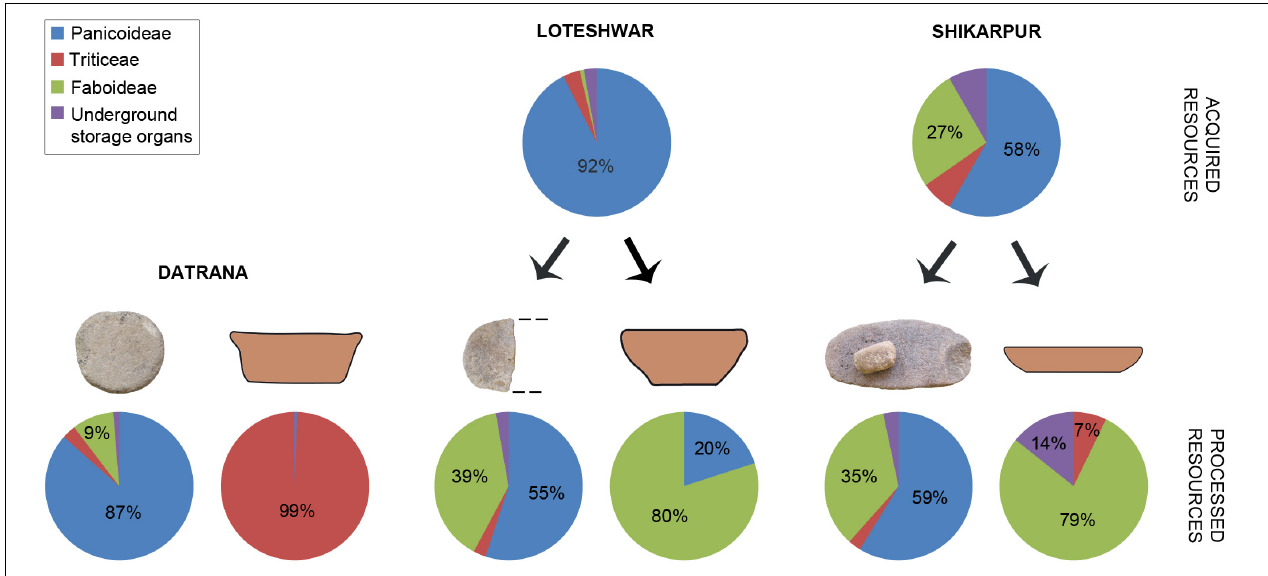
FIGURE 4 | Plant foodways at Datrana, Loteshwar and Shikarpur. Comparison of the main groups of starch-rich plants identified in archeological sediments (acquired resources), grinding stones (ground resources) and pottery vessels (cooked resources). Very few macrobotanical remains were found at Datrana (García-Granero et al., 2017a) and therefore have not been included in this figure. Raw data can be found in Supplementary Table 2 . Panicoideae: several small millet species and Job’s tears; Hordeeae: wheat and barley; Faboideae: several pulses, including horsegram and Vigna sp.; Underground storage organs: ginger and other unidentified resources. TABLE 4 | Plant foodways at Datrana, Loteshwar and Shikarpur. Acquired resources Ground resources Cooked resources